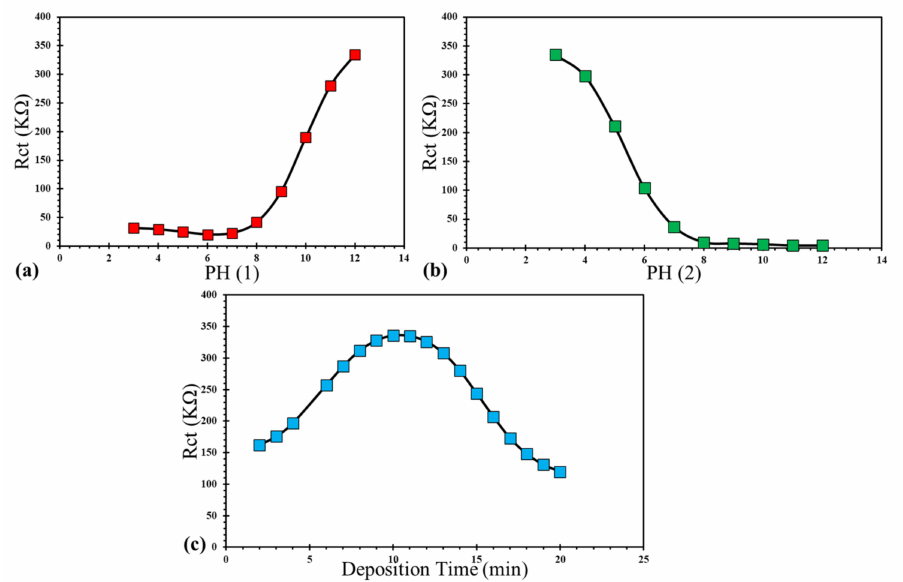
Figure 12. The effect of ( a ) pH (1), ( b ) pH (2), and ( c ) deposition time on the Rct of CeCCs obtained from the ANFIS model. Each diagram is plotted by assuming a constant value for other parameters.